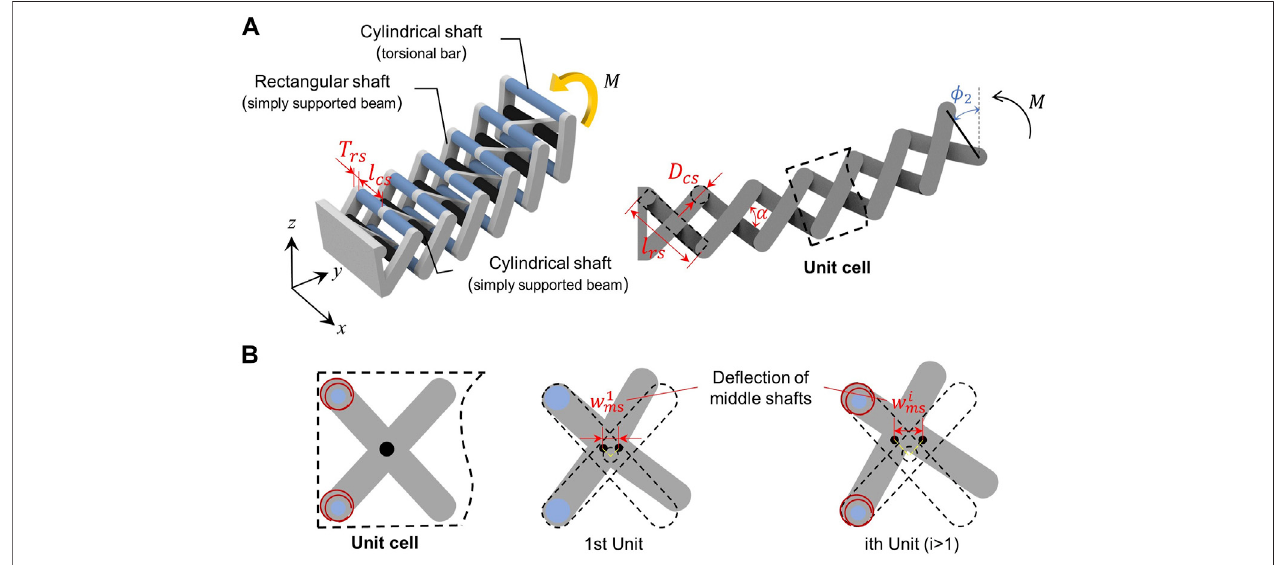
FIGURE4| Ribwithmodi fi edpantographicmetastructure. (A) Illustrationand geometric de fi nition ofmodi fi edpantographicmetastructure composed ofrepeated unit cells; (B) De fl ection of black shafts induced by bending (for the fi rst unit cell) and rigid body rotation (for the i th unit, i > 1).